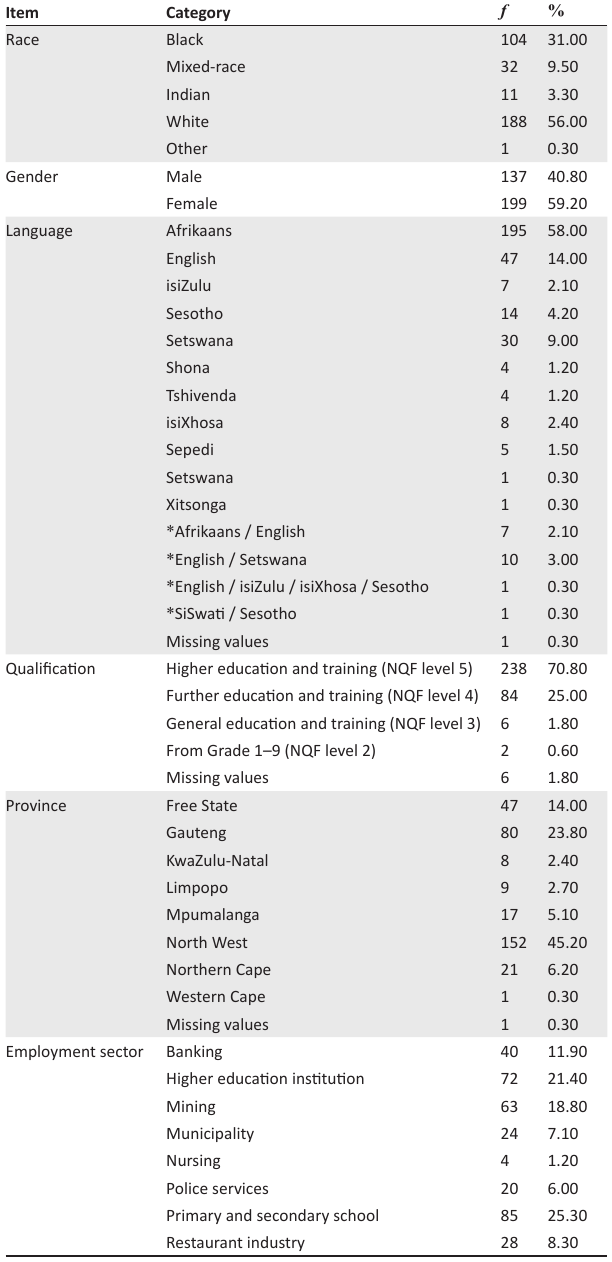
TABLE 1: Characteristics of participants ( N =